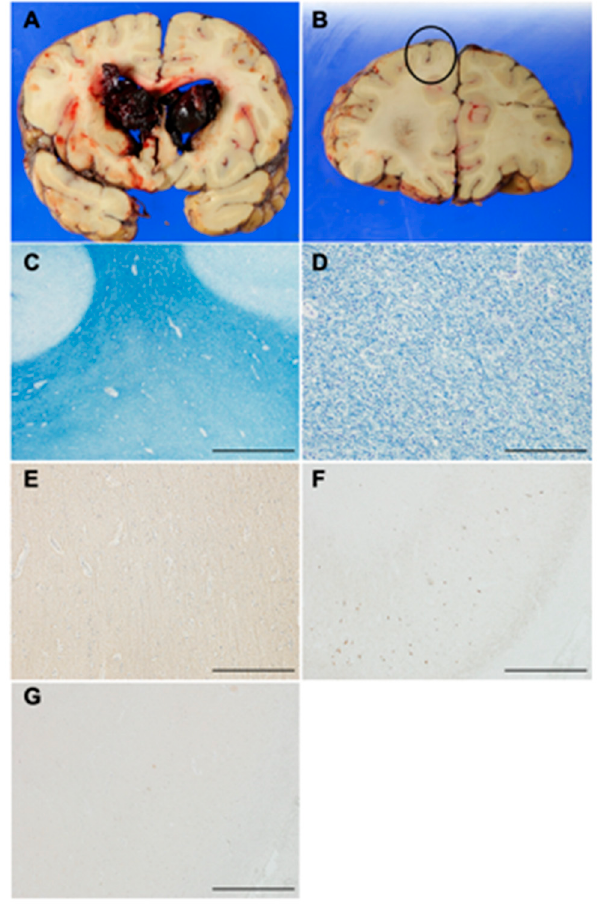
Figure 6. Postmortem study of a case of NSTLC. Macroscopic view of the bilateral cerebral hemispheres shows that right thalamic hemorrhage is comorbid with intraventricular rupture ( A ), but subcortical white mater is preserved ( B ), where histological analysis was carried out (( B ), circle; ( C , D , E )). Photomicrographs of Klüber–Barrera (( C ), scale bar: 5 mm; ( D ), scale bar: 200 μ m), neurofilament heavy weight (( E ), scale bar: 200 μ m), phosphorylated tau ( F ), scale bar: 1 mm), and amyloid beta (( G ), scale bar: 1 mm) staining.